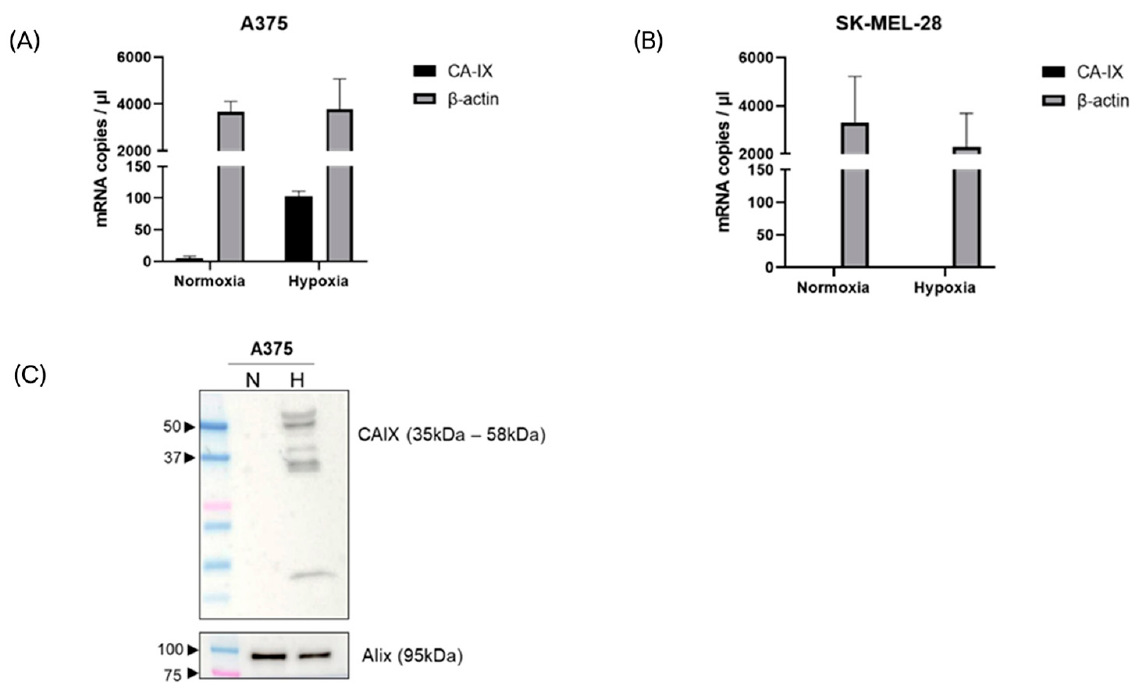
Figure 3. CA-IX mRNA expression in melanoma-derived sEVs, released under normoxic and hypoxic conditions. After RNA isolation, CA-IX and beta actin mRNA copies were measured by ddPCR in the A375 model ( A ) and SK-MEL-28 model ( B ). ( C ) CA-IX protein expression was in- duced in A375-derived sEVs released under hypoxia. Alix blot was used to con fi rm the EV iden- tity.